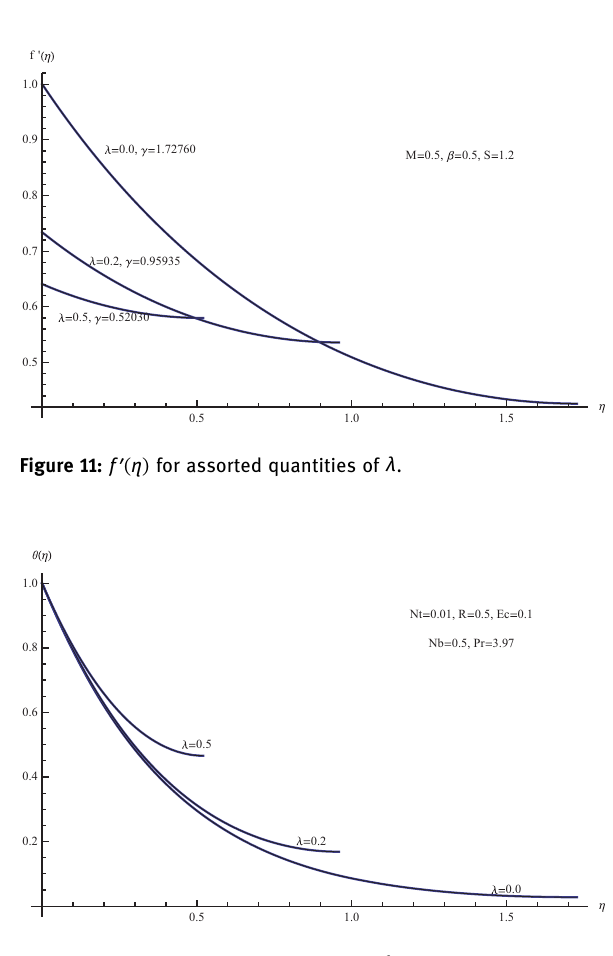
Figure 12: ( ) θ η for assorted quantities of λ .